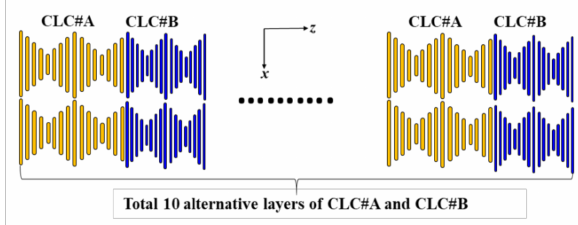
Figure 1. Schematics of using bichiral liquid crystal polymer films (BLCPFs) comprising alternate layers of cholesteric liquid crystal#A (CLC#A) and